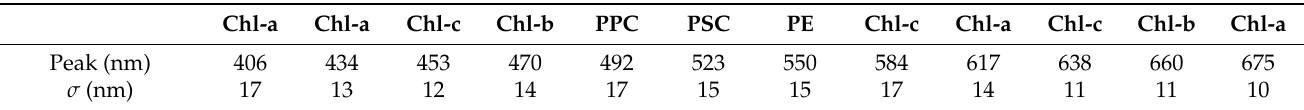
Table 2. Although biliproteins were not analyzed in this work, one peak was assigned to phycoerythrin to ensure good fits. Table 2. Central wavelengths of the Gaussian peak and the widths ( σ ) of the Gaussian functions are assigned for different phytoplankton pigments (PE =